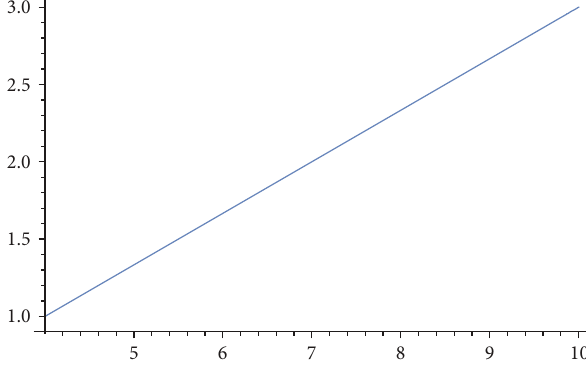
ð m Þ resulting from the s q (cid:1) q , for a heavy quark q (cid:1) q